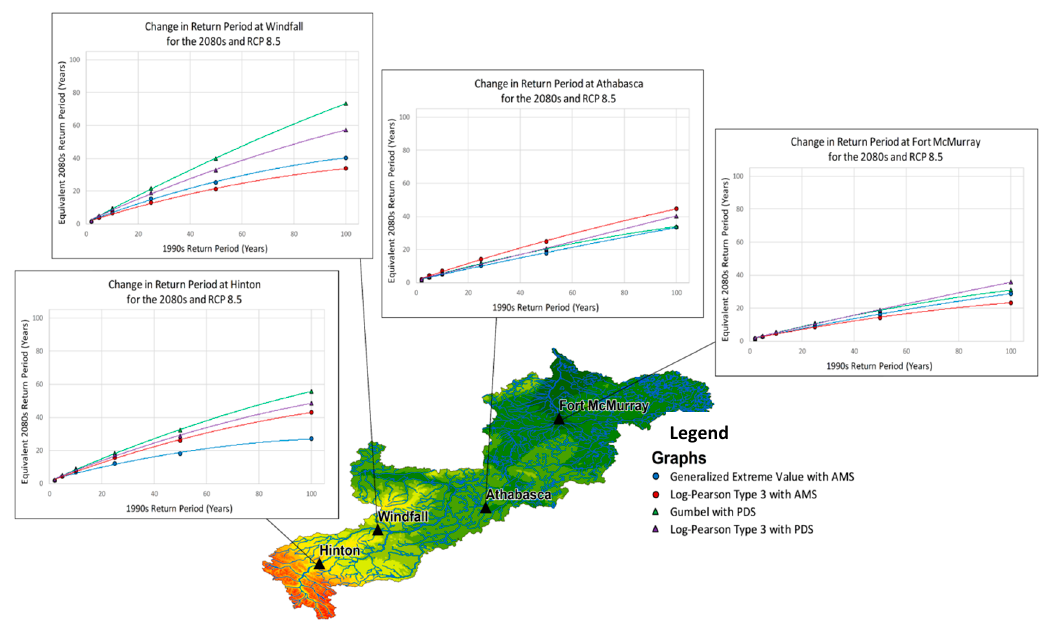
Figure 7. Results of stationary analysis - ensemble mean projected changes in flood events of different return periods between the 1990s baseline and the 2080s future periods corresponding to the RCP8.5 emissions scenario.